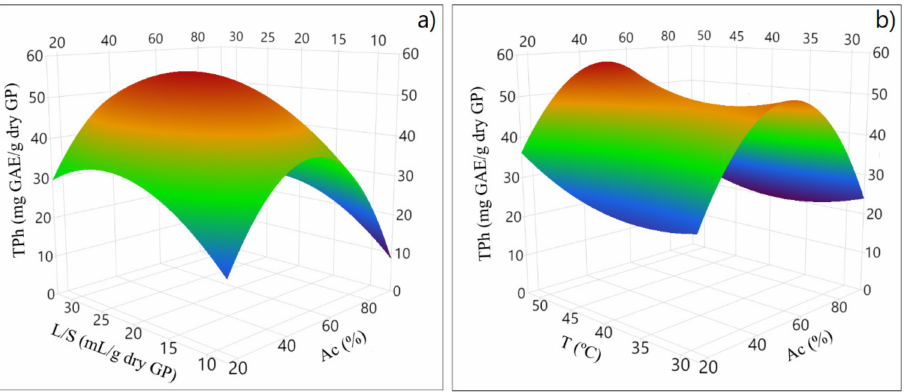
Figure 6. Response surface plots for the effect of ( a ) liquid–solid ratio (L/S) and acetone concentration (Ac) and of ( b ) temperature (T) and acetone concentration (Ac) on total phenolic content